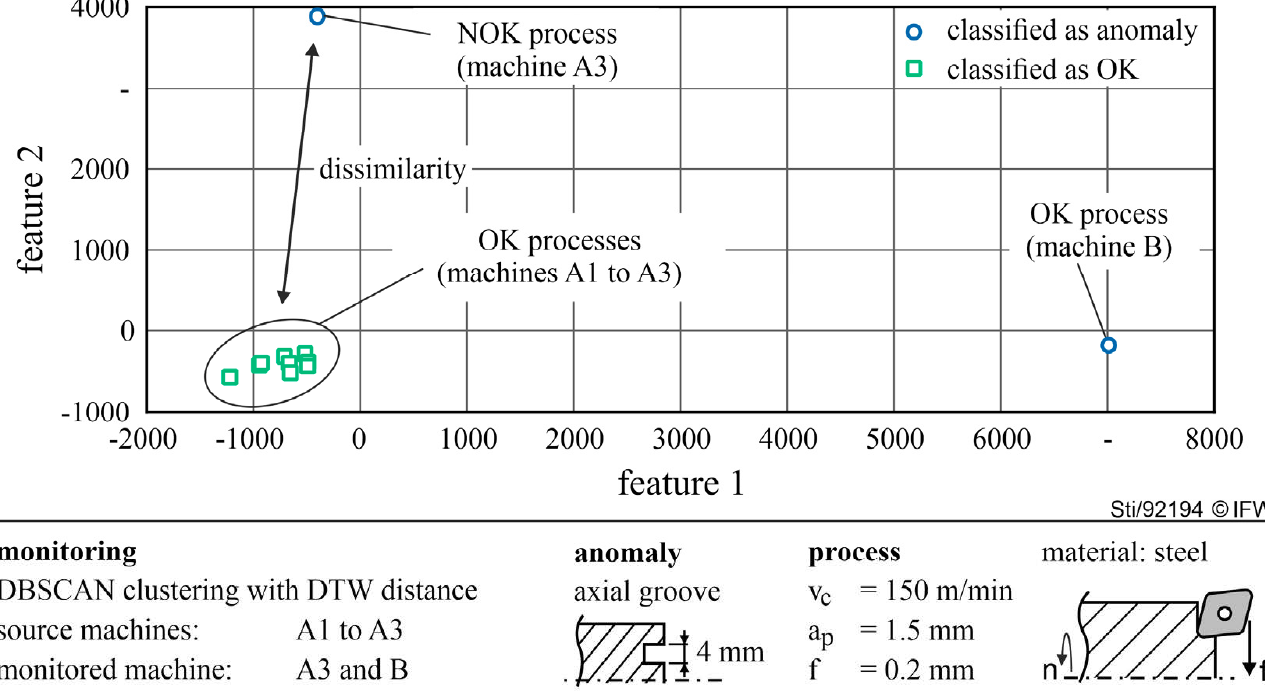
Figure 10. Similarity of signals for face turning operations on different machines visualized via multidimensional scaling. The DBSCAN algorithm falsely classifies the OK-process of machine B as an anomaly.